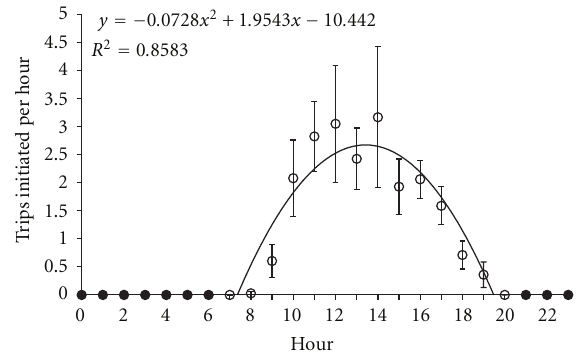
Figure 3: The average number of trips taken per hour by O. cornifrons . Hour 0 is 12:00 am and hour 23 is 11:00 pm. Error bars indicate standard error. Only the open circles were used to deter- mine the regression